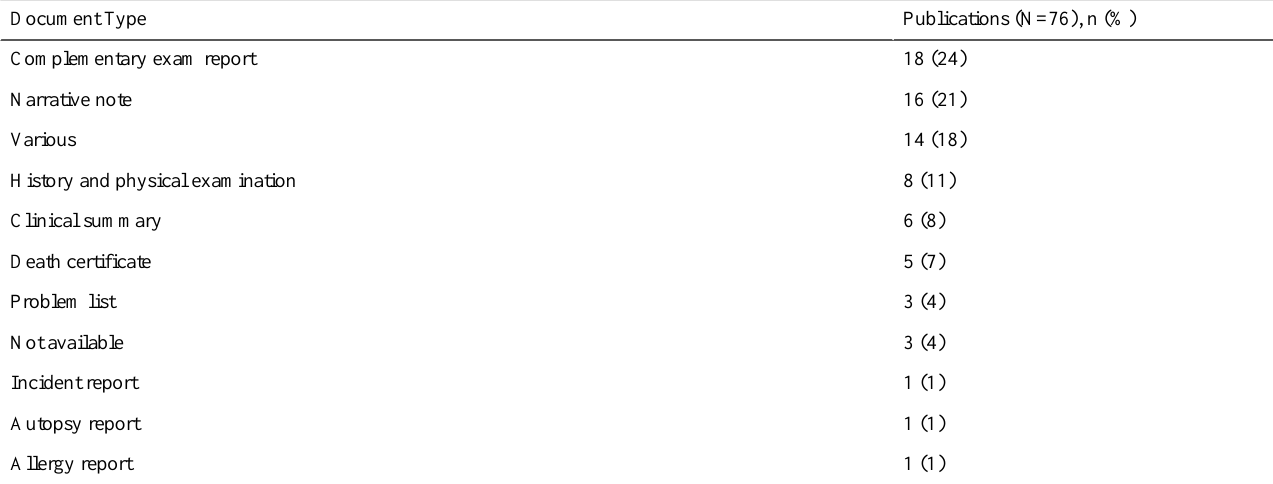
Table 2. Number of publications per type of document used for the mapping.